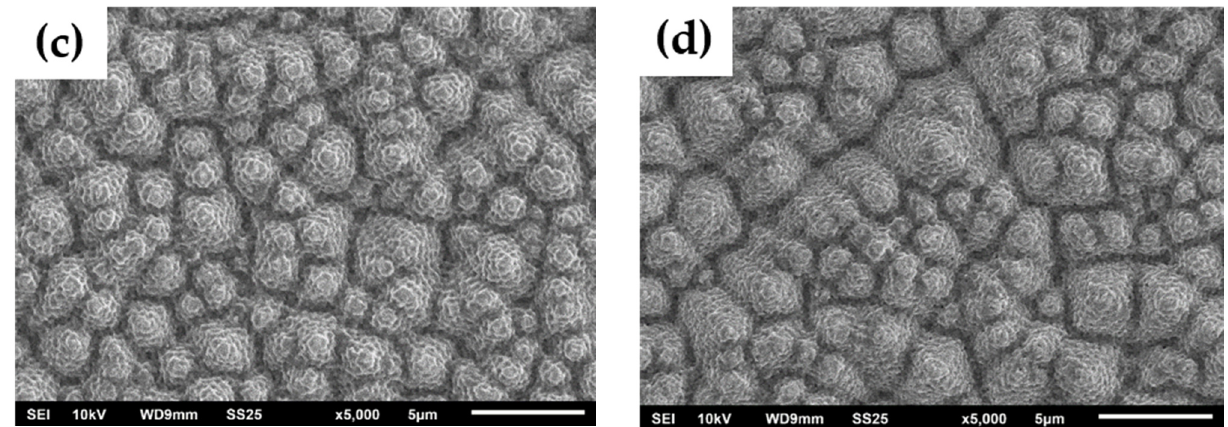
Figure 1. SEM images for the Cu/AZO/Si samples annealed at ( a ) 300, ( b ) 500, ( c ) 600, and ( d ) 800 °C. The cross-sectional views of SEM for the Cu/AZO/Si samples annealed at 400, 600,